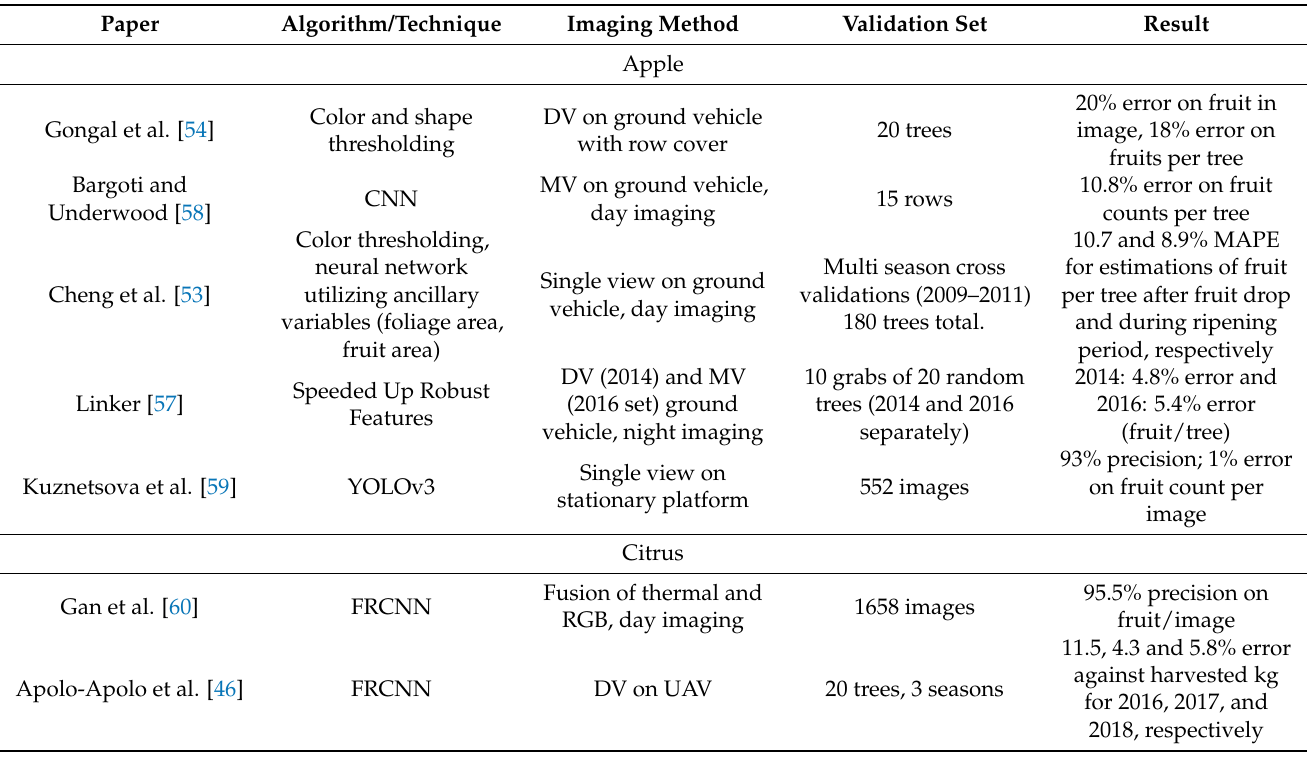
Table 4. Example reported results of machine vision-based estimation of tree fruit load. Papers are ordered chronologically within commodities. Single view refers to collection of one image per tree and one row side only. Dual view (DV) refers to collection of one image per tree side from each interrow and multi view (MV) entails collection of several images in succession per tree side.